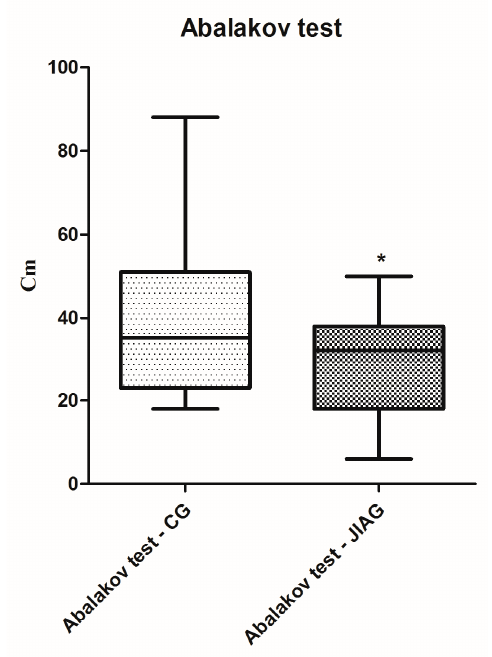
Figure 3. Analysis of Abalakov performances among the group of healthy subjects (CG) and subjects with juvenile idiopathic arthritis (JIAG). * indicated that p < 0.05.